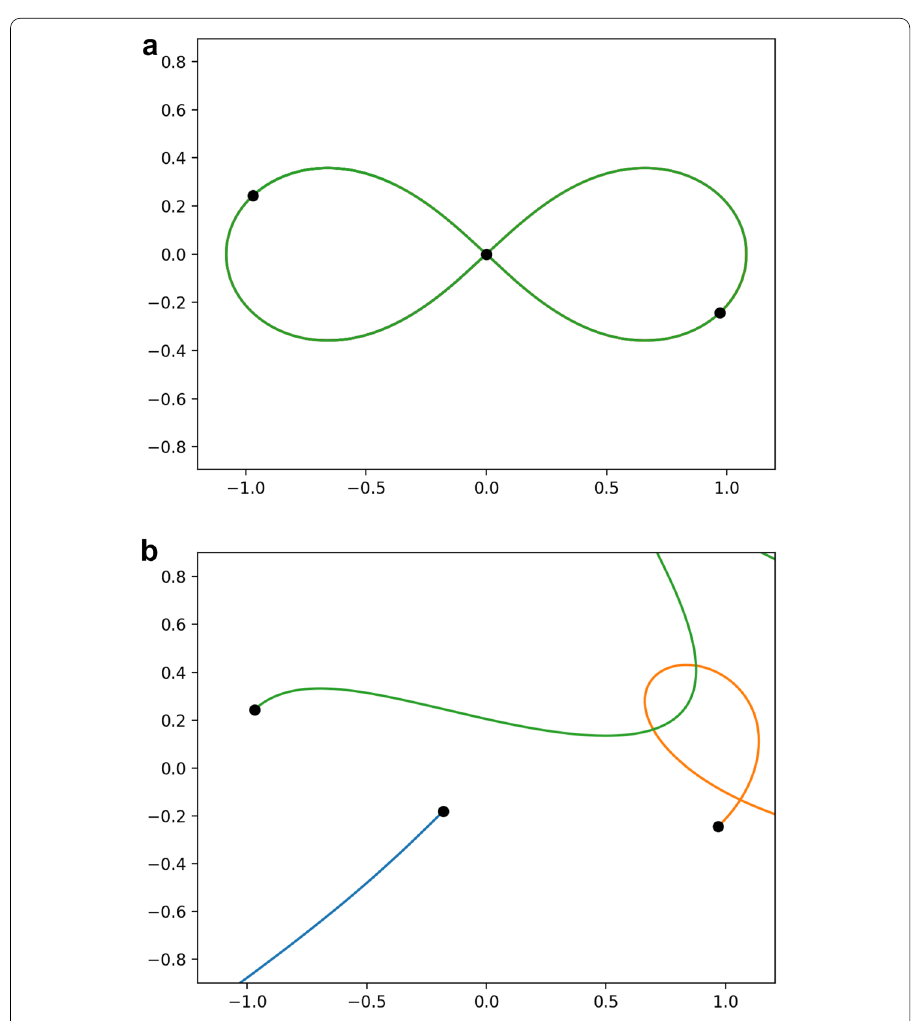
Fig. 6 Three-body problem. Figure-eight orbit ( a ) and perturbed ( b ) initial positions and trajectories